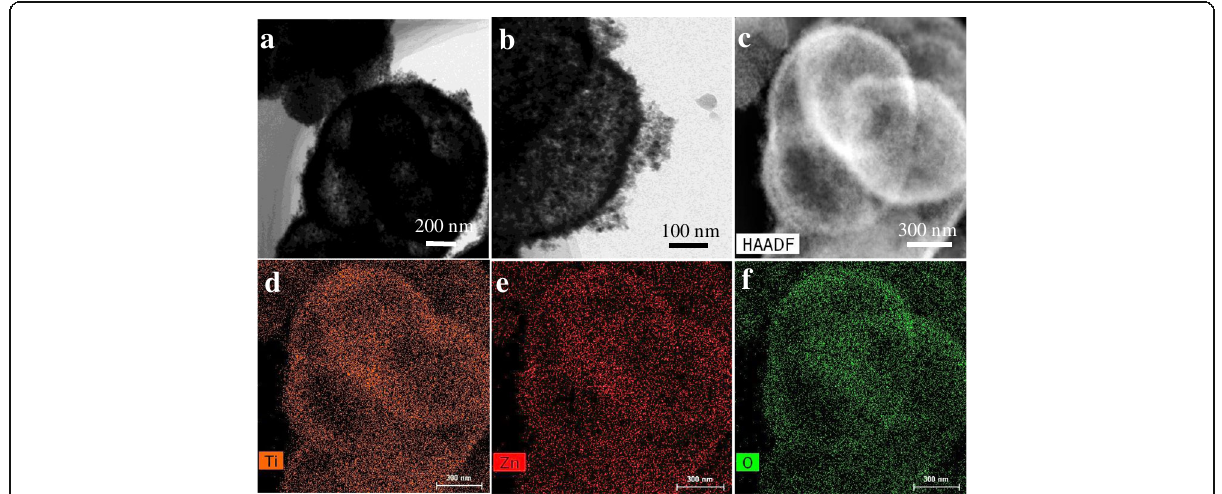
Fig. 2 a TEM, b magnified TEM, and c STEM images of ZnO@TiO 2 hollow spheres; Corresponding EDS elemental mappings of c indicating the uniform distribution of d Ti, e Zn, and f O, respectively